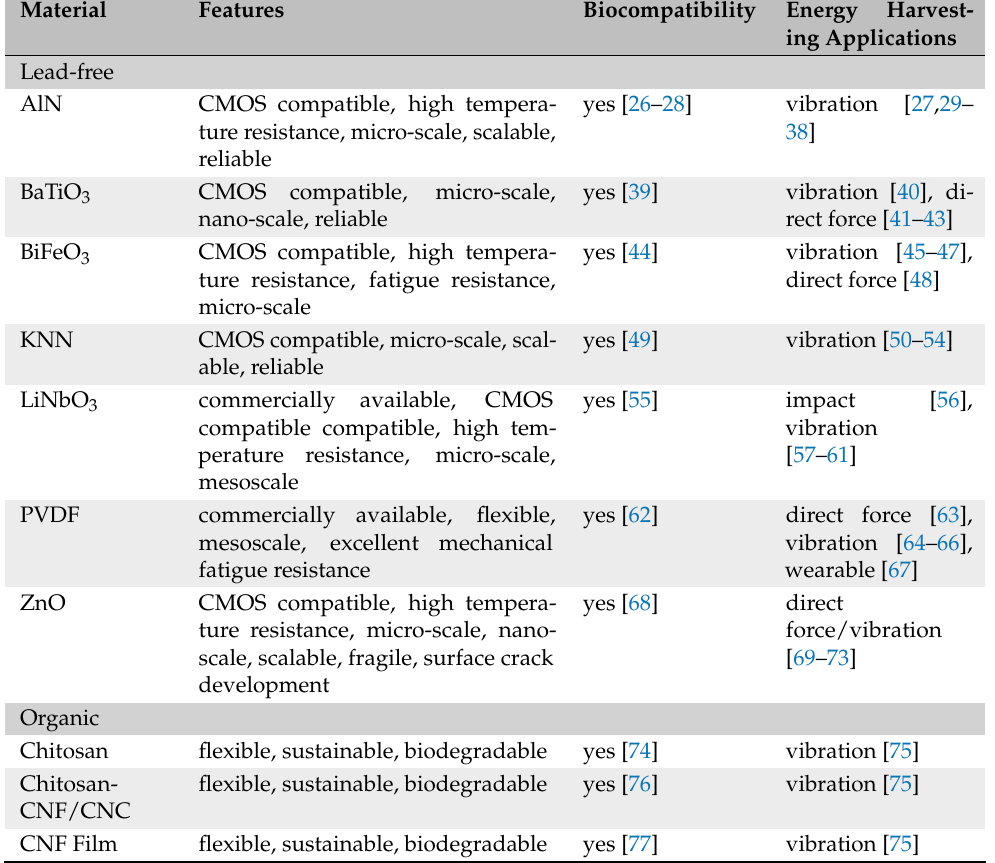
Table 1. Comparison of features, biocompatibility and energy harvesting applications for different innovative piezoelectric